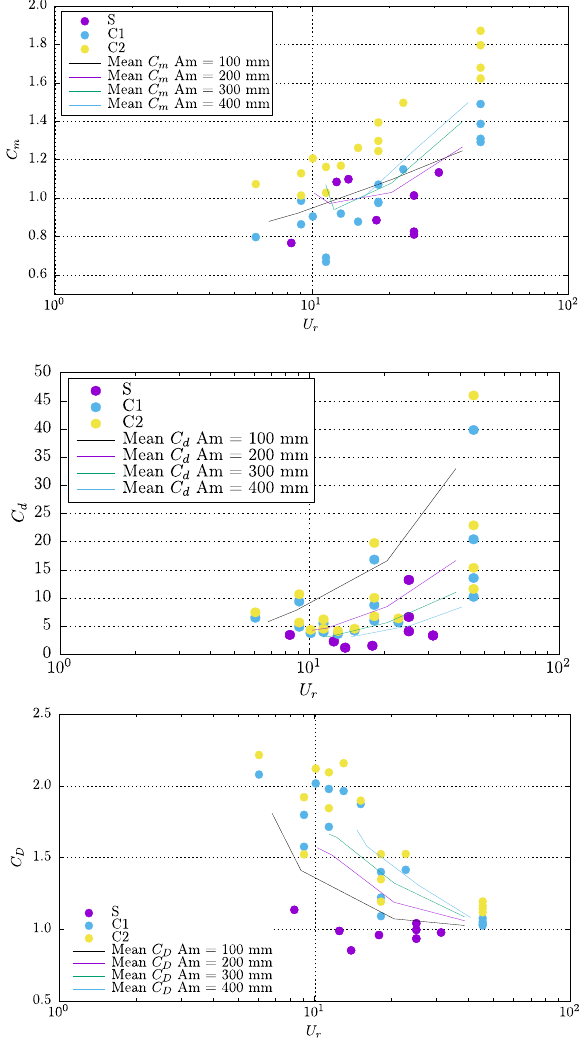
Figure 13. Evolution of C m , C d and C D vs. U r for the S, C1 and C2 cases.